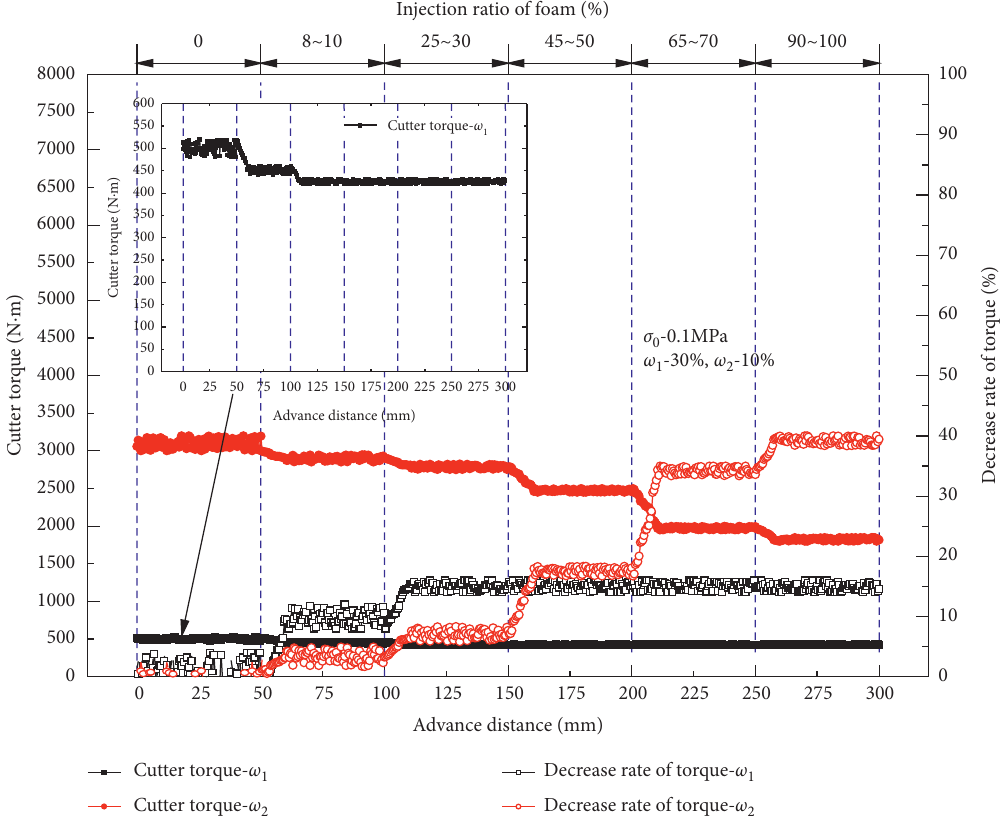
Figure 21: Effect of foam conditioning and soil water contents on cutter torque at soil pressure